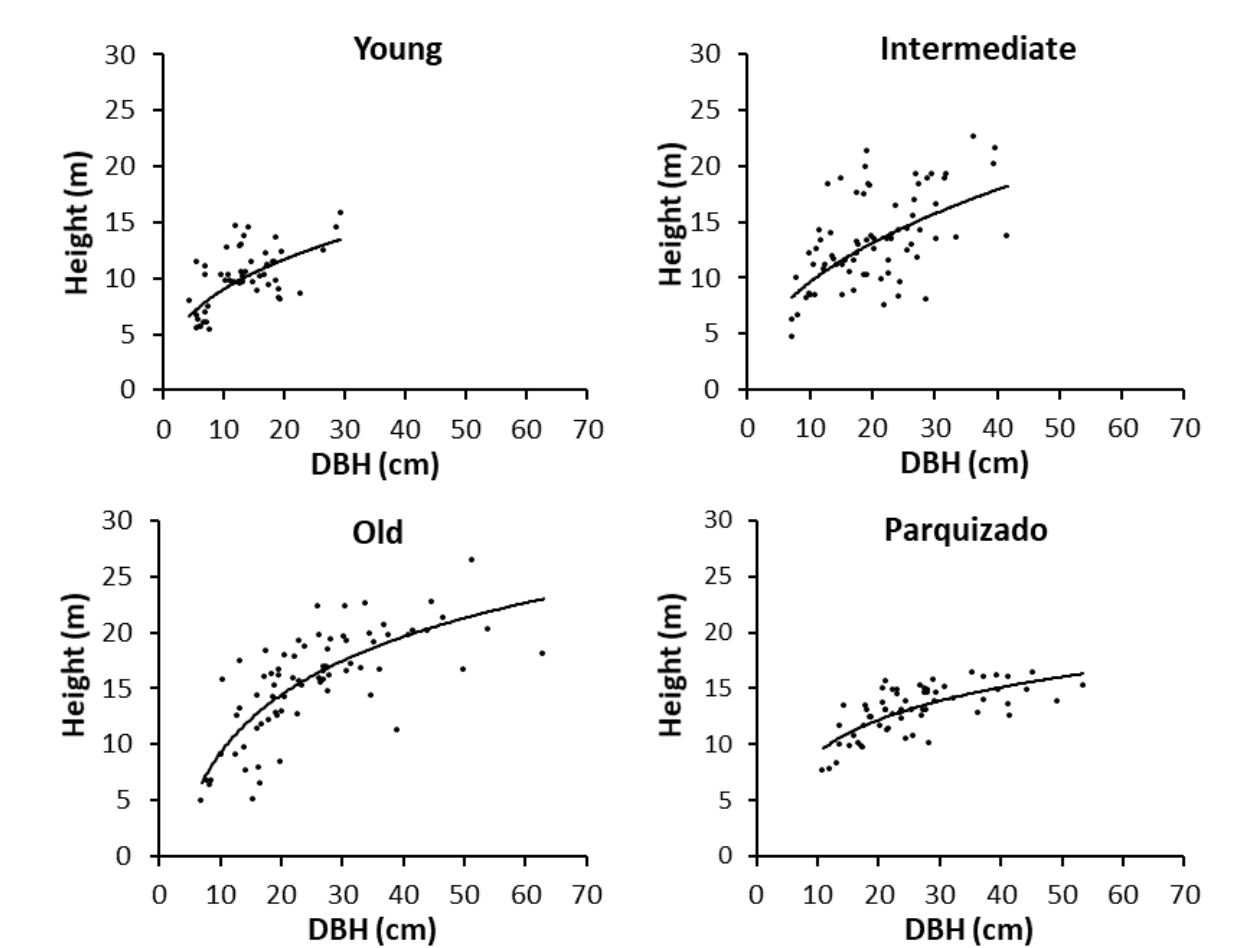
Figure 4. Height curve of the different structures. Table 4. Quality parameters of the different structures: Absolute and relative values are